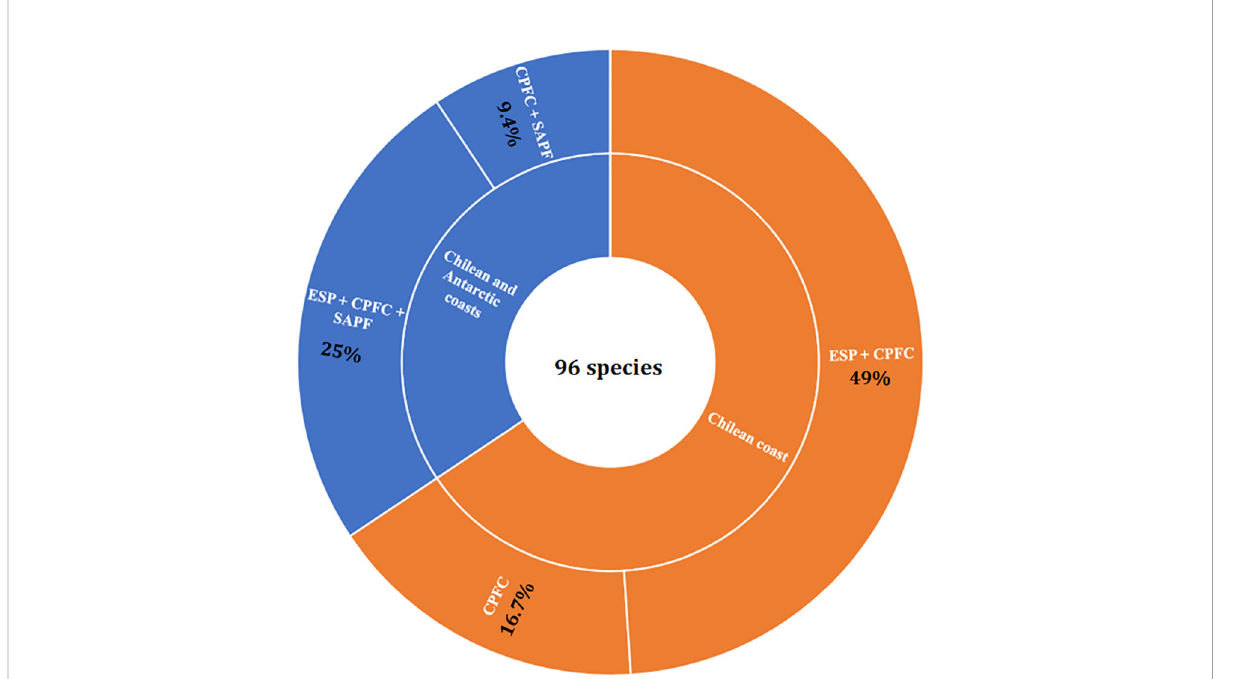
FIGURE 5 Latitudinal distribution ranges of the species recorded in the KNR waters. Species with distribution ranges north of 42°S are named as Eastern South Paci fi c (ESP); species distributed between 42° and 56°S are named as CPFC; species with a distribution range south of 65°S are classi fi ed as south of Antarctic polar front